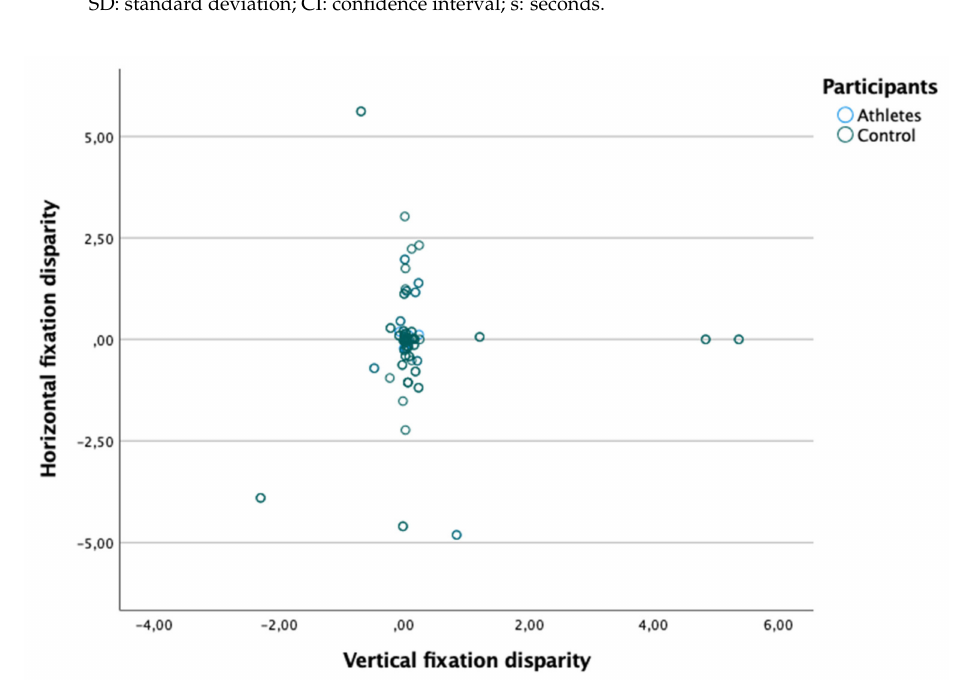
Figure 3. Absence of relationship between the horizontal and vertical fixation disparity.